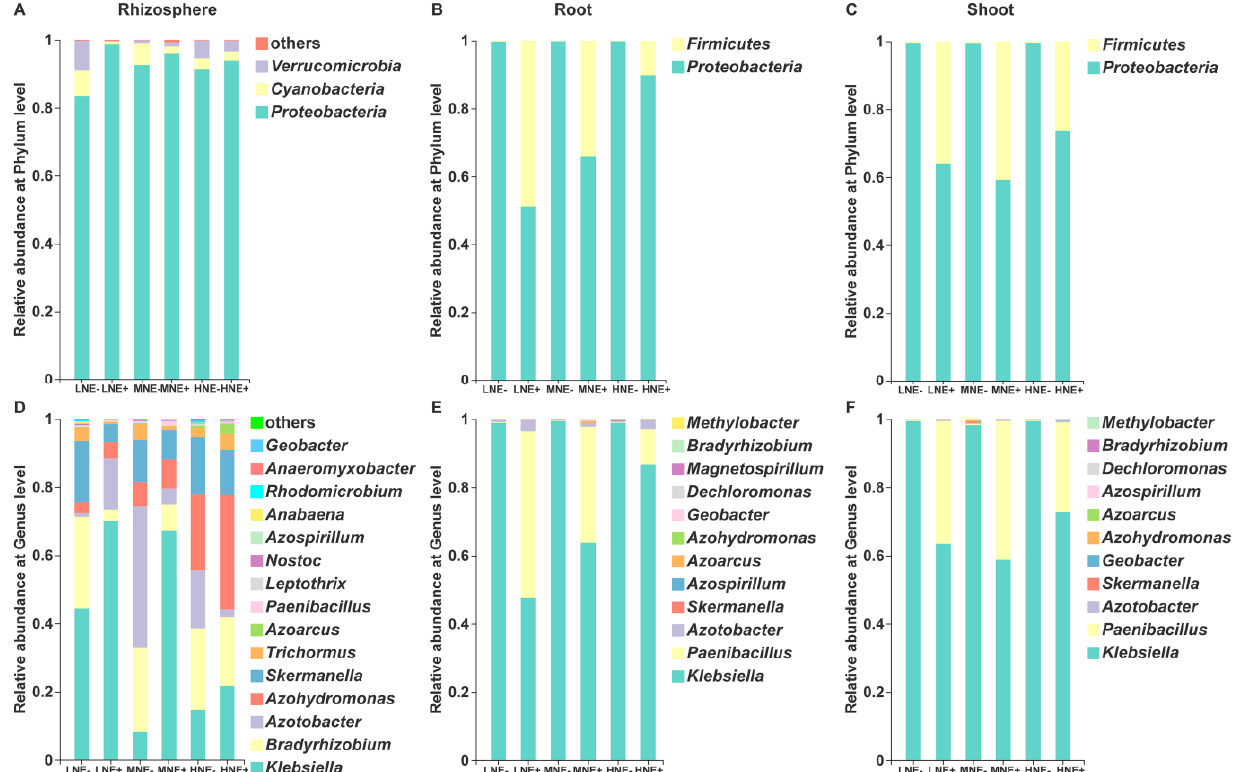
Figure 6. The composition of the diazotrophic communities in the rhizosphere and root/shoot endosphere at the phylum level ( A – C ) and genus level ( D–F ). LNE − : low nitrogen without inoculation; LNE+: low nitrogen with inoculation; MNE − : moderate nitrogen without inoculation; MNE+: moderate nitrogen with inoculation; HNE − : high nitrogen without inoculation; HNE+: high nitrogen with inoculation. The results were obtained based on the nifH sequencing. The statistical comparison of the relative abundance of diazotrophs in the rhizosphere, roots and shoots at the genus level is shown in Figure S3. The composition of the diazotrophic communities filtered out from all of the Paenibacillus reads are shown in Figure S4.